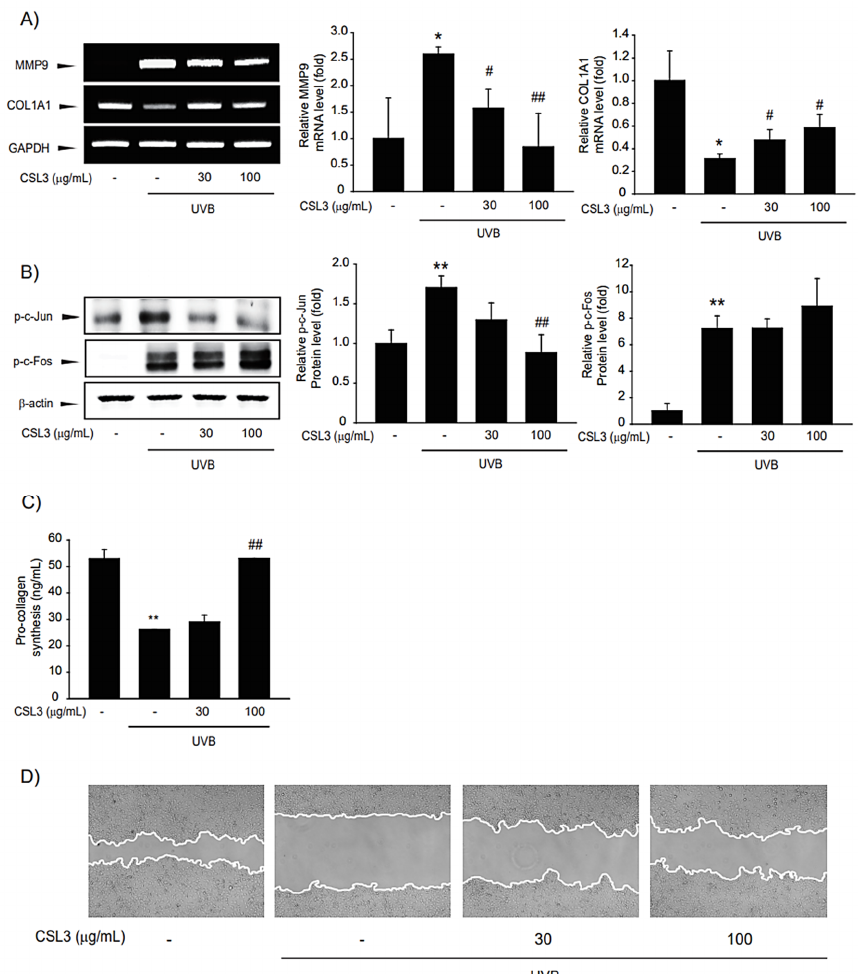
Figure 7. Effect of CSL3 on MMP9 and collagen expression in HaCaT cells. ( A ) First, we pre-treated with CSL3 (30–100 µ g/mL) for 1 h in HaCaT cells. Then, the cells were exposed to UVB irradiation (30 mJ/cm 2 ), followed by incubation with CSL3 for 3 h. mRNA levels of MMP9 and collagen were evaluated using RT-PCR analysis. Data represent means ± S.E. of 3 replicates; significant when compared with respective controls, * p < 0.05, compared with the UVB irradiation group, # p < 0.05, ## p < 0.01. ( B ) We first pre-treated with CSL3 (30–100 g/mL) for 1 h in HaCaT cells. Then, the cells were exposed to UVB irradiation (30 mJ/cm 2 ), followed by incubation with CSL3 for 3 h. Protein expression of AP-1 was visualized using immunoblo(cid:308)ing. Data represent means ± S.E. of 3 replicates; sig- nificant when compared with respective controls, ** p < 0.01, compared with the UVB irradiation group, ## p < 0.01. ( C ) HaCaT cells were pretreated with CSL3 (30–100 g/mL) for 1 h. Cells were then irradiated with UVB irradiation (30 mJ/cm 2 ), followed by incubation with CSL3 for 6 h. Pro-collagen expression was measured by using Pro-collagen Type I C-peptide EIA Kit. Data represent means ± S.E. of 3 replicates; significant when compared with respective controls, ** p < 0.01, compared with the UVB irradiation group, ## p < 0.01. ( D ) Wound-healing assay. We first pre-treated with CSL3 (30– 100 g/mL) for 1 h in HaCaT cells. Then, the cells were exposed to UVB irradiation (30 mJ/cm 2 ),